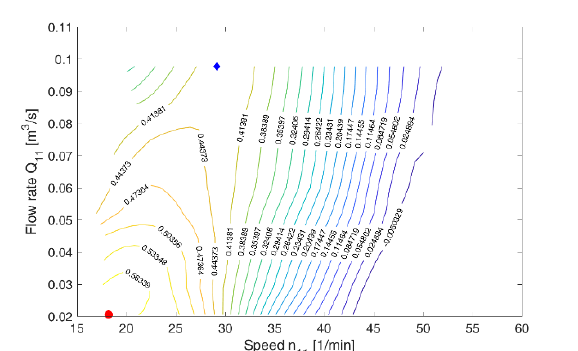
Fig. 12. Q 11 n 11 diagram for configuration, bucket -20 and channel edge position -80 for different flow rates.